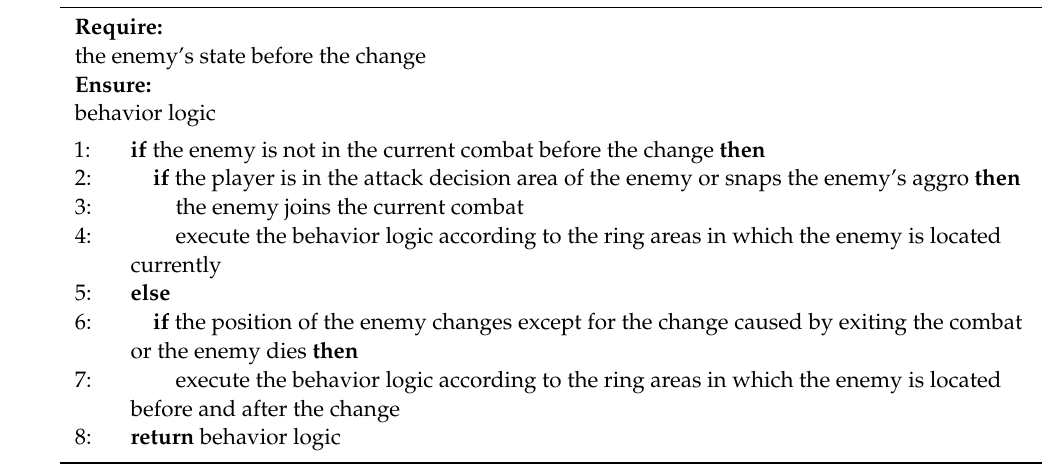
Algorithm 2 IBAI-RID Algorithm-Change